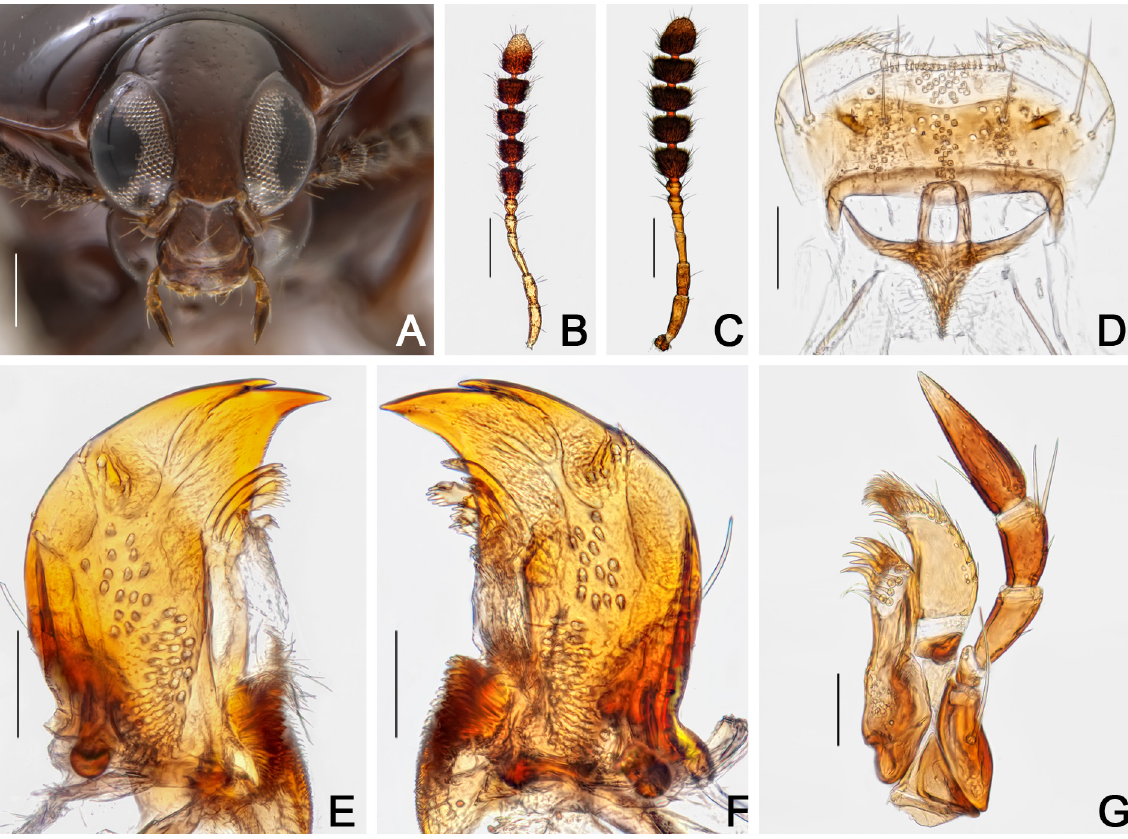
Fig. 15. Cyparium lescheni sp. nov. A . Holotype, ♂ (CELC), frontal view. B . Paratype, ♂ (CELC), antennae. C . Paratype, ♀ (CELC), antennae. D–G . Paratype, ♂ (CELC). D . Labrum. E . Left mandible. bars: A–C = 0.2 mm; D–G = 0.05